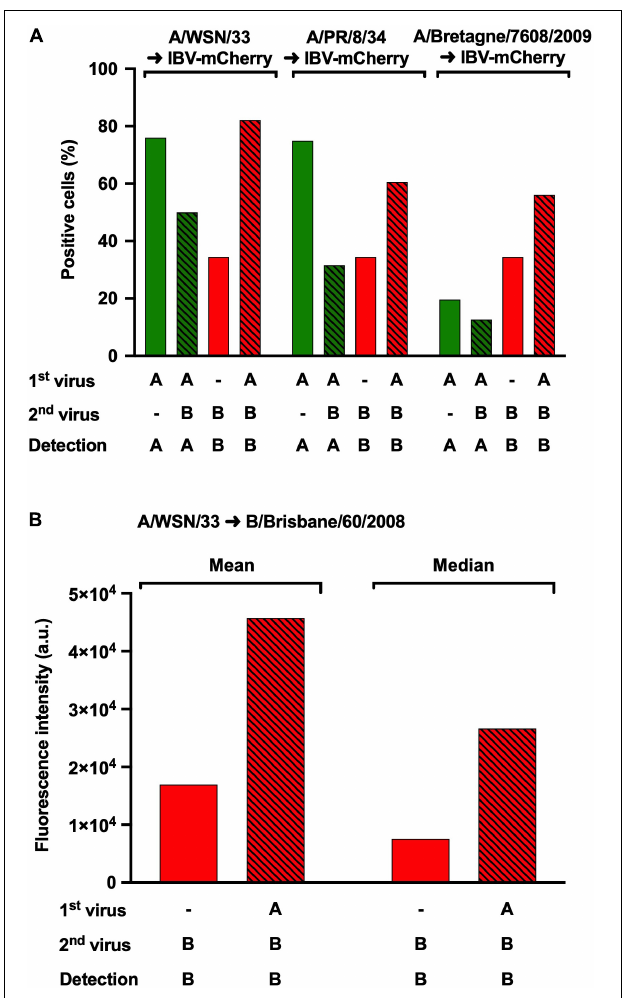
FIGURE 4 | Effect of heterotypic co-infections using different strains of IAV. (A) A549 cells were infected with IAV strains A/WSN/33, A/PR/8/34 or A/Bretagne/7608/2009 for 1 h and then infected with IBV-mCherry for 6 h. Infected cells were labeled for the NP protein from IAV and analyzed by flow-cytometry for NP A or mCherry expression. The solid bars represent the proportion of fluorescent cells expressing NP A (in green) or mCherry (in red) upon control infections with one of the indicated IAV strains or IBV-mCherry alone, respectively. The hatched bars represent the proportion of fluorescent cells expressing NP A (in green) or mCherry (in red) upon co-infections. One experiment representative of three independent experiments performed in monoplicate is shown (see Supplementary Figures S2A,B ). (B) A549 cells were infected for 1 h with A/WSN/33 and then infected with B/Brisbane/60/2008 for 6 h. Infected cells labeled for the NP protein of IBV were detected by flow cytometry. The solid bars represent the mean or median fluorescence intensity upon control infection with B/Brisbane/60/2008 alone. The hatched bars represent the mean or median fluorescence intensity upon co-infection with A/WSN/33 and B/Brisbane/60/2008. One experiment representative of two independent experiments performed in monoplicate is shown (see Supplementary Figure S2C ). a.u., arbitrary units.